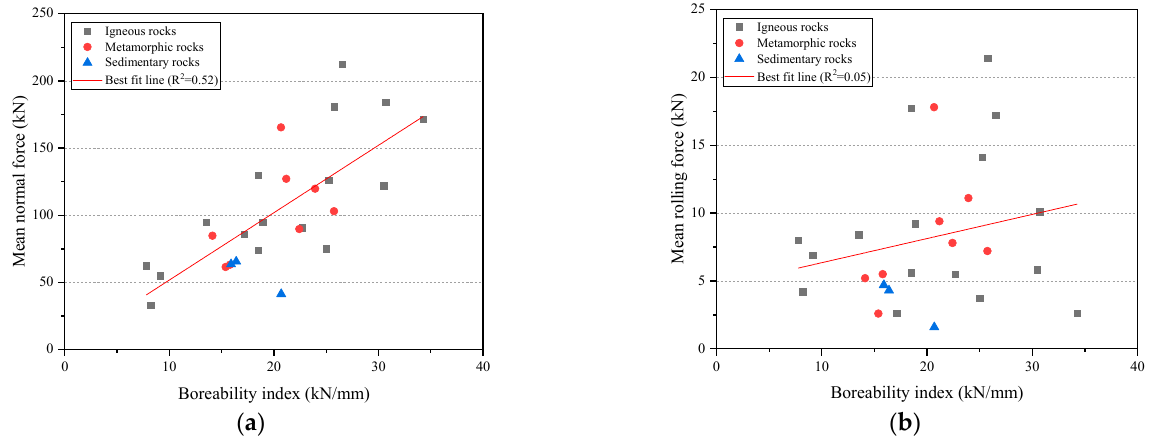
Figure 5. Relationship between cutter forces and boreability index: ( a ) normal force; ( b ) rolling force. The rolling force is usually estimated based on the empirical relationship between the normal force and the rolling force. This relationship can be expressed as the concept of the cutting coefficient (CC), which is defined by the ratio of the rolling force to the normal force. As shown in Figure 6a, the average CC for the Korean rock types included in this study was 8% on average, and the CC range was consistent with the findings of previous studies [30,37]. However, as shown Figure 6b, there are no significant relationships between CC and rock strengths in the database. The result is not consistent with the finding from the previous study